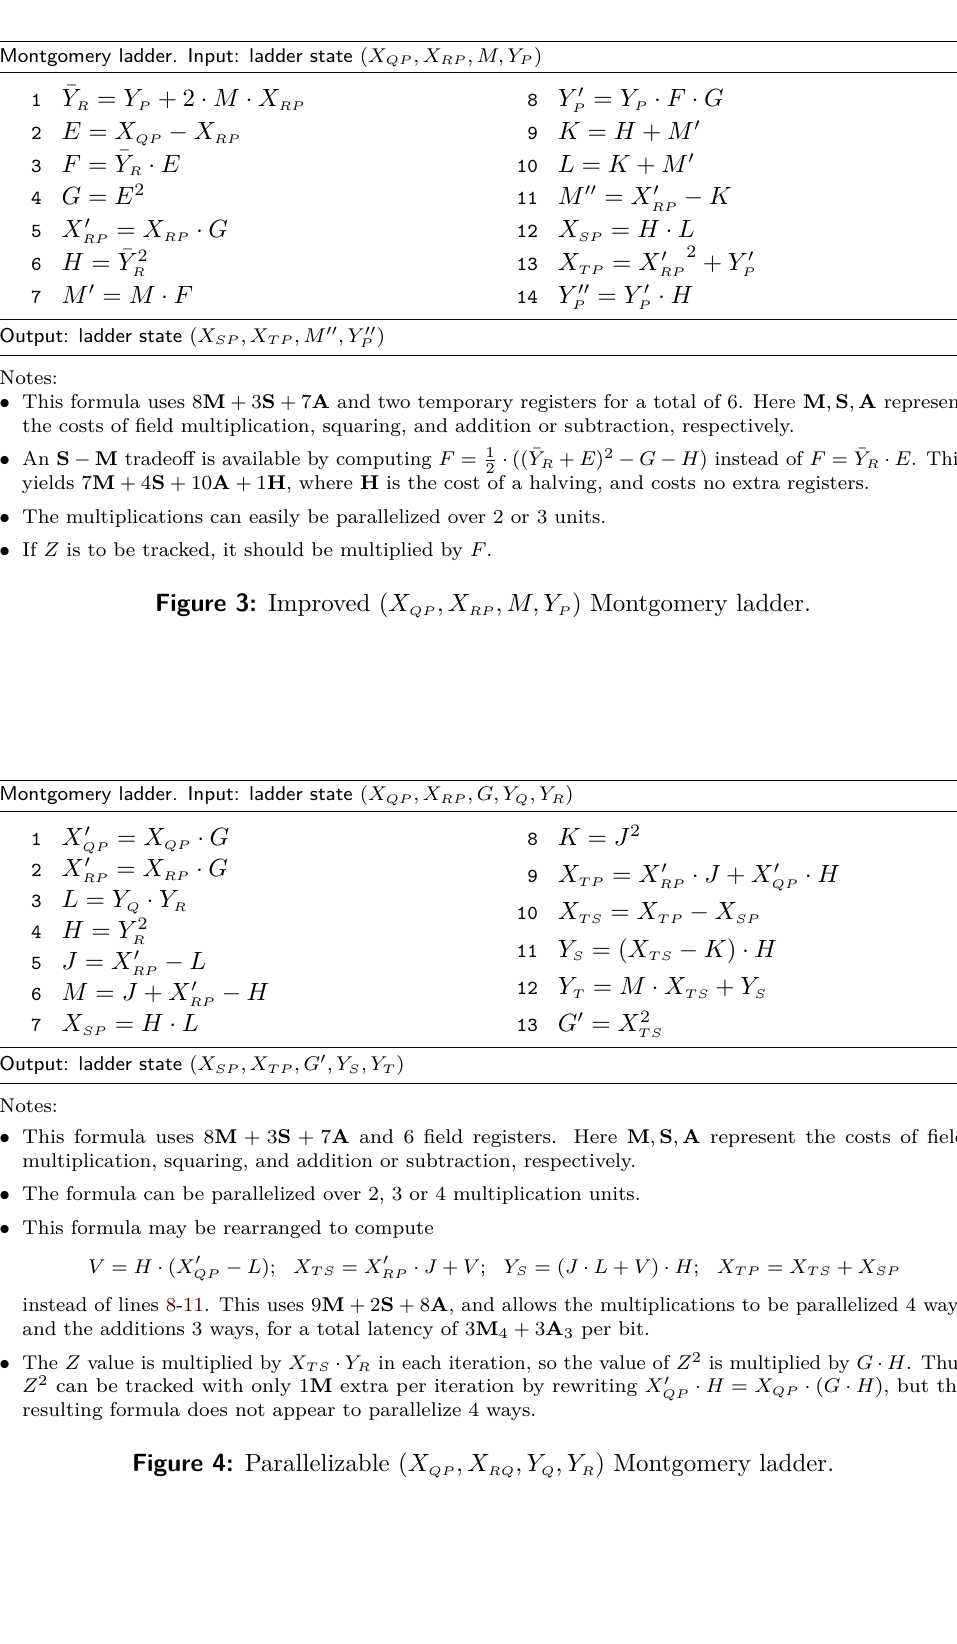
, X , Y , Y ) Montgomery QP RQ Q R